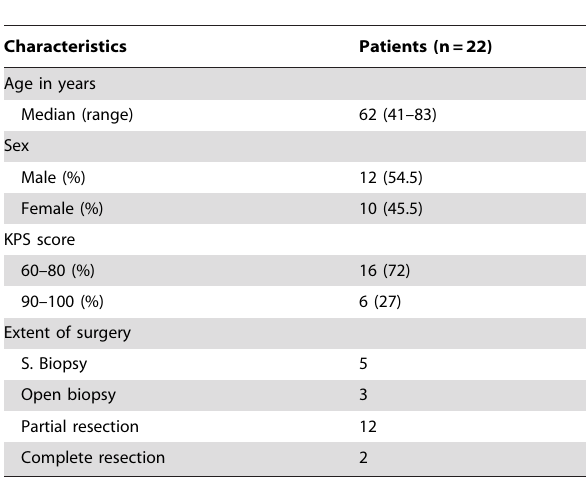
Table 1. Clinical characteristics of